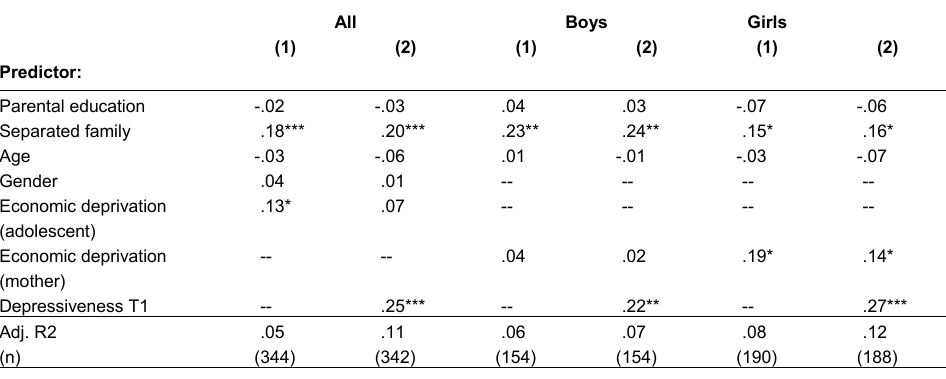
Table 5 : Effects of economic deprivation on offspring depressiveness six years later All